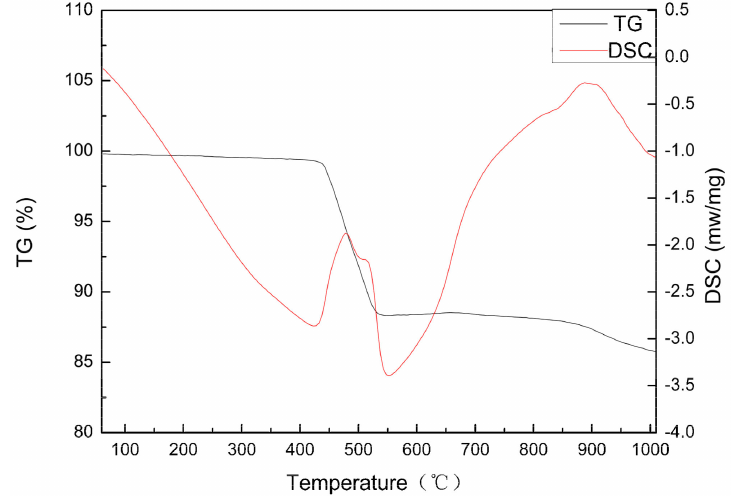
Figure 1. TG curve of the rare earth concentrate.